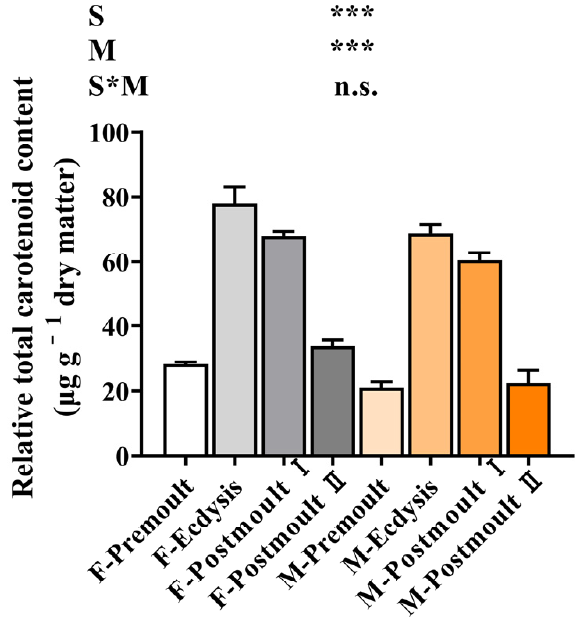
Figure 4. Effects of sex and moult stages on the total carotenoid content ( µ g g − 1 dry weight) of the edible part of mud crab. Columns represent means with bars indicating a standard error (n = 3). Two-way ANOVA p -values are shown in each panel, with “S” representing the effects of sex, “M” representing the effects of moulting stages, and “S*M” representing the interaction between sex and moulting stages. n.s., not significant ( p ≥ 0.05). The differences were considered statistically significant at values of *** p < 0.001.